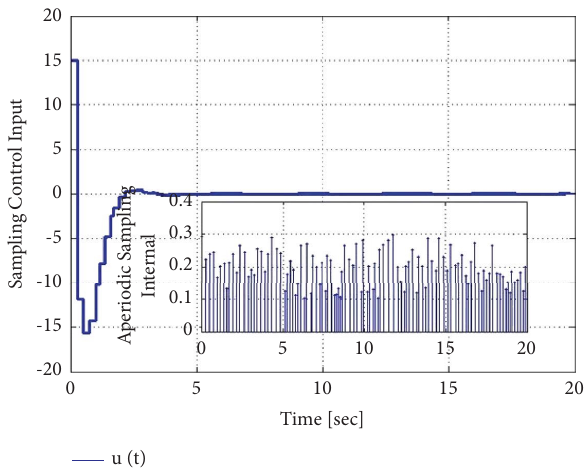
Figure 2: Sampled-data control input and aperiodic sampling intervals in